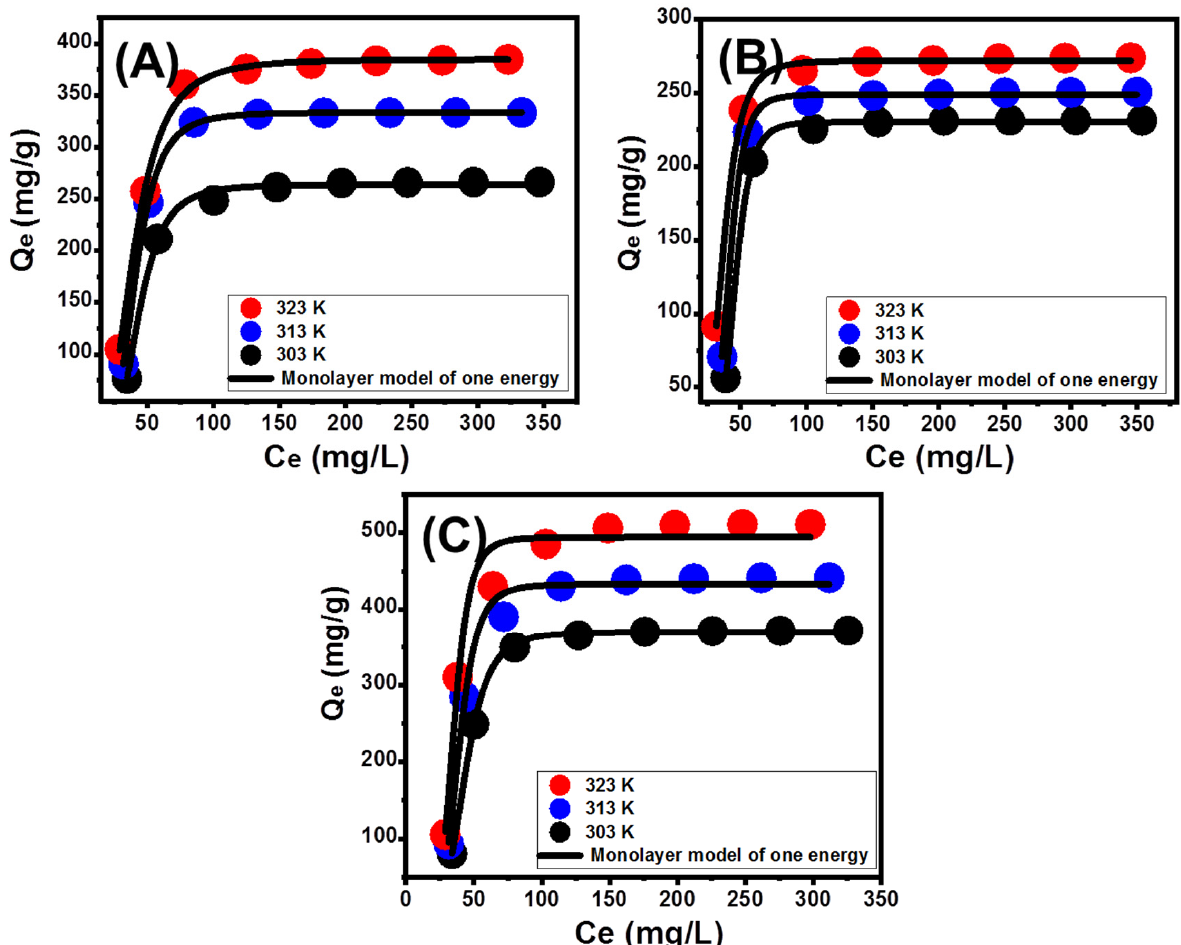
Figure 5. Fitting of the Zn (II) retention results by CA ( A ), L.CA ( B ), and M.CA ( C ) with advanced monolayer isotherm model of one energy site.